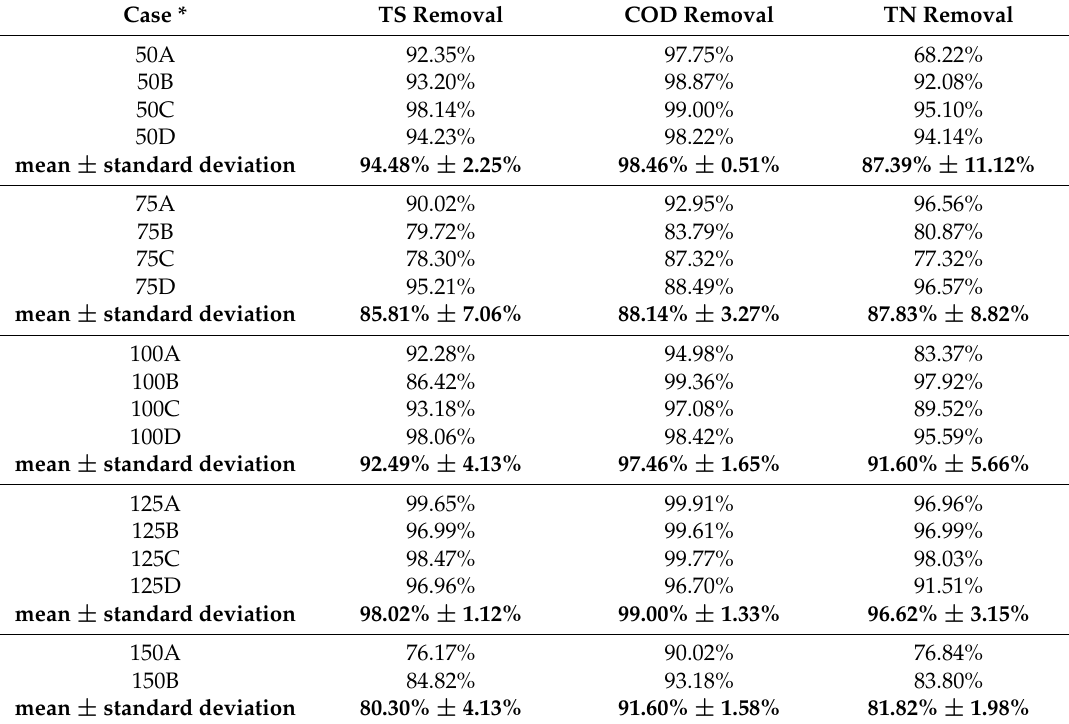
Table 5. Treatment performance in Phase II of the experiment.